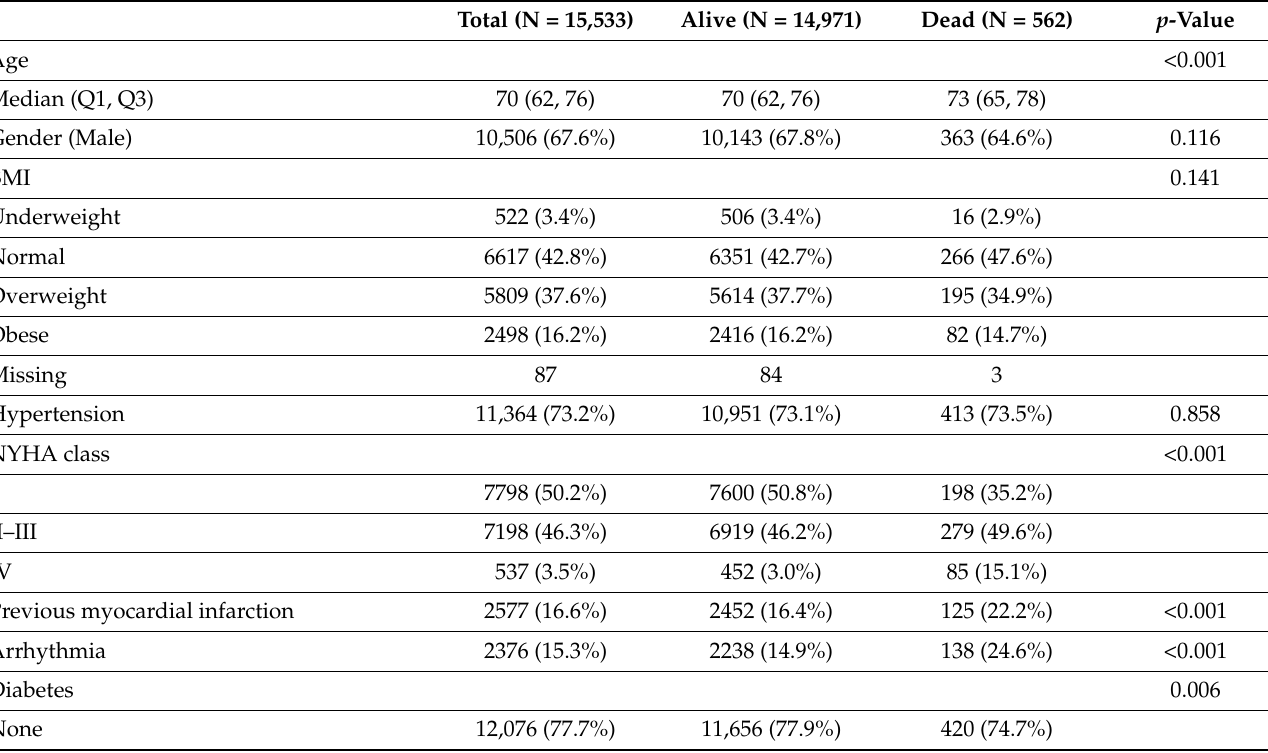
Table 1. Patient description and comparison between alive and dead patients ( p -values were com- puted with Wilcoxon – Mann – Whitney test for the continuous variables and chi-squared test for the